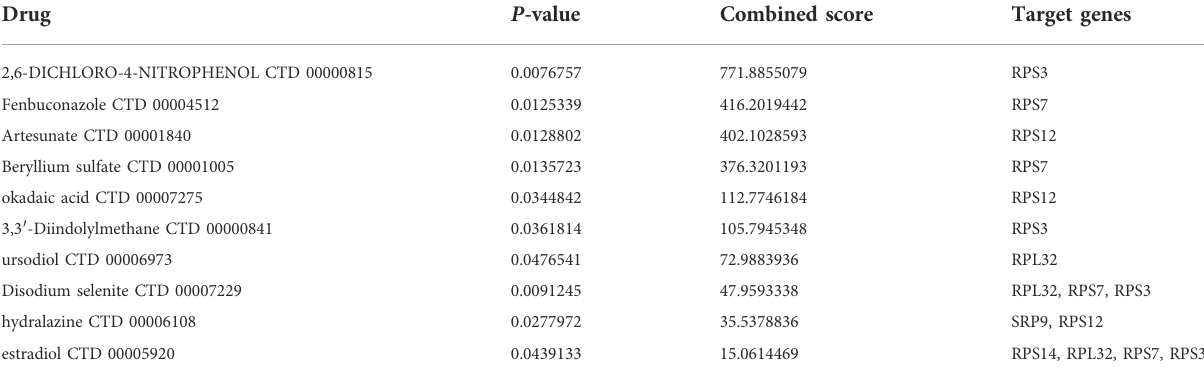
TABLE 3 Potential drugs that may have regulatory effects on the seven SRP-DGs. Drug P